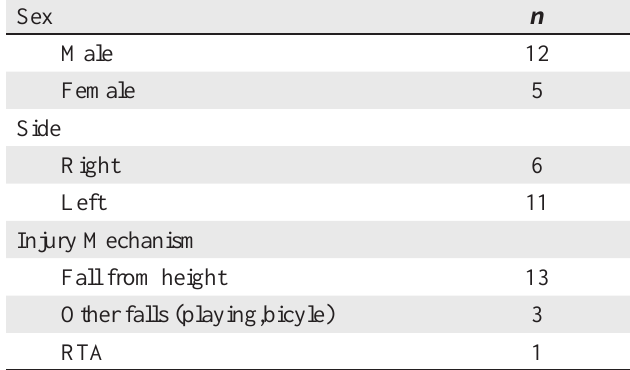
Table 2 : Patient details